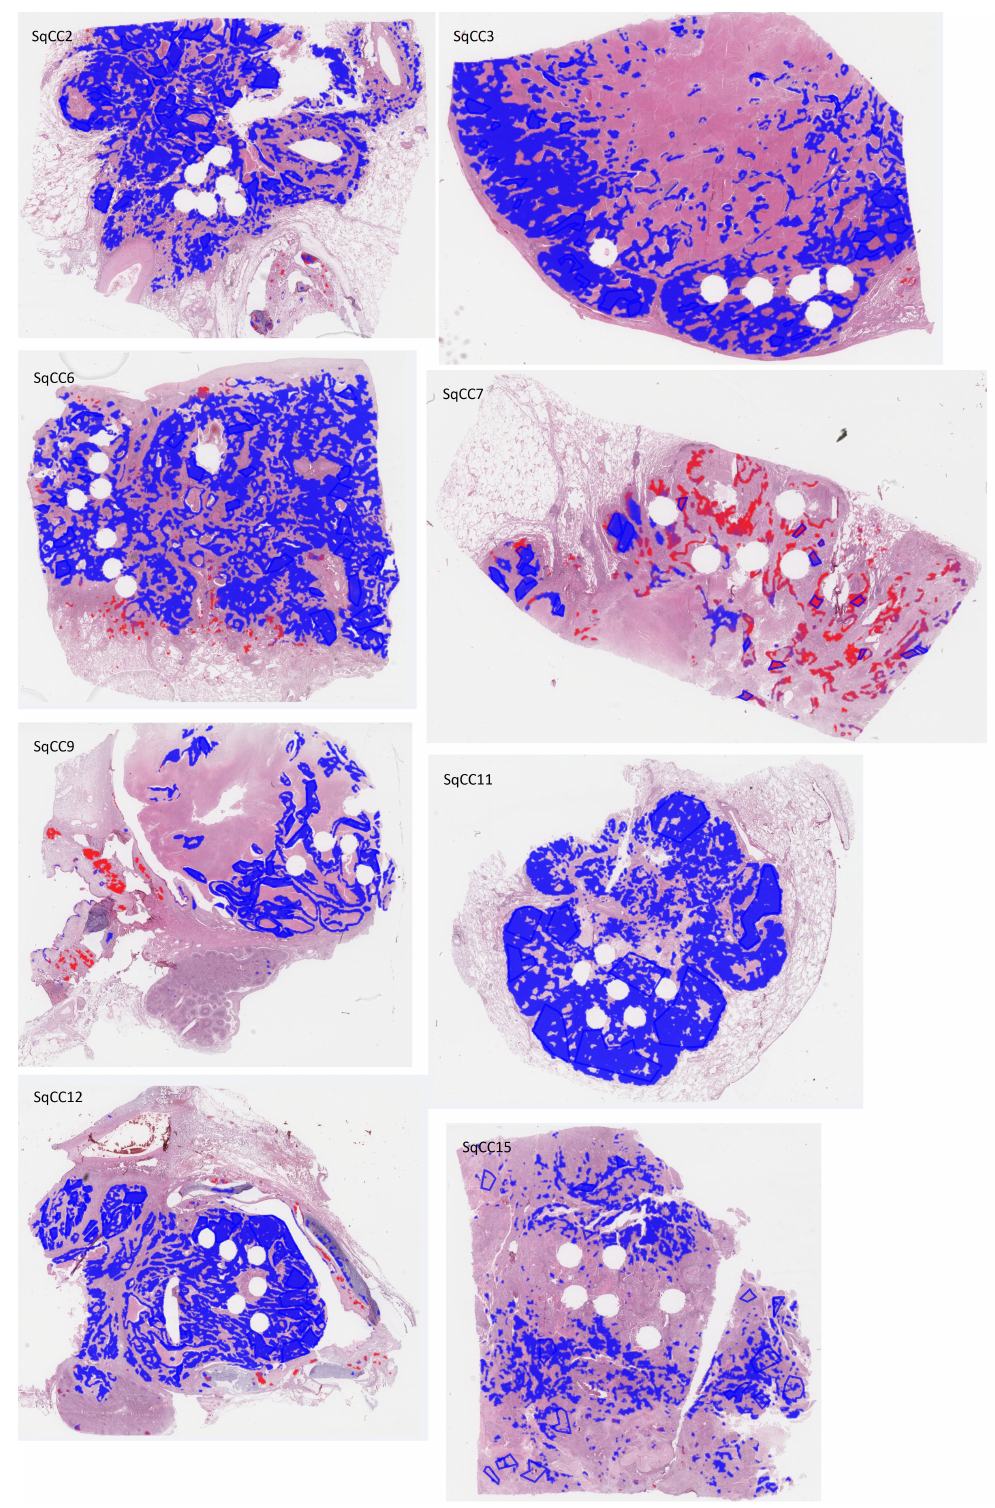
Figure A4. H&E-stained whole-slide images of test sections with overlaid annotations (red lines: ADC, blue lines: SqCC) and heatmaps (red filling: ADC, blue filling: SqCC) of the ADC/SqCC classification of network MALDI2